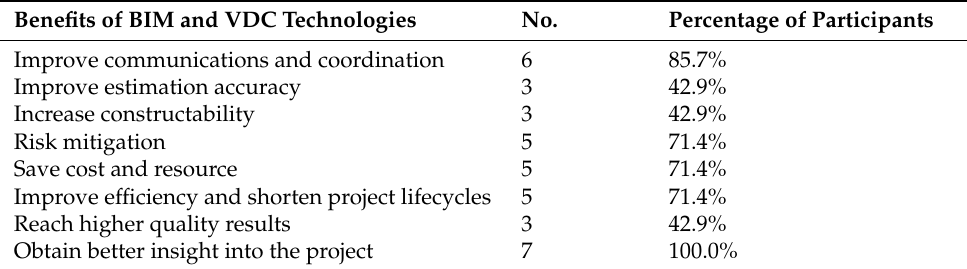
Figure 5. Digital Construction Framework for the Future. Table 2. Benefits of BIM and VDC